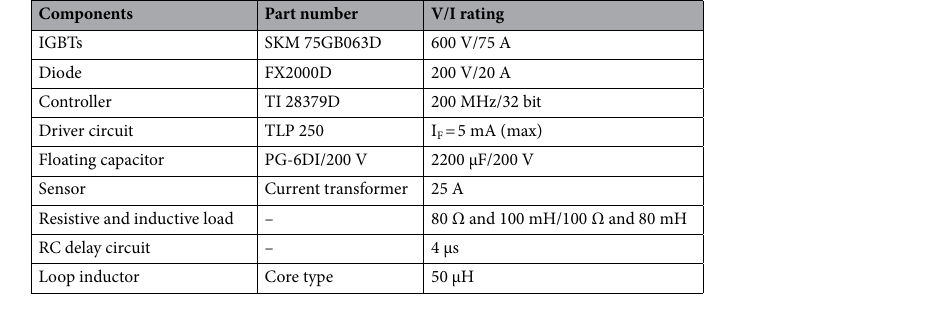
Table 4. Experimental parameter